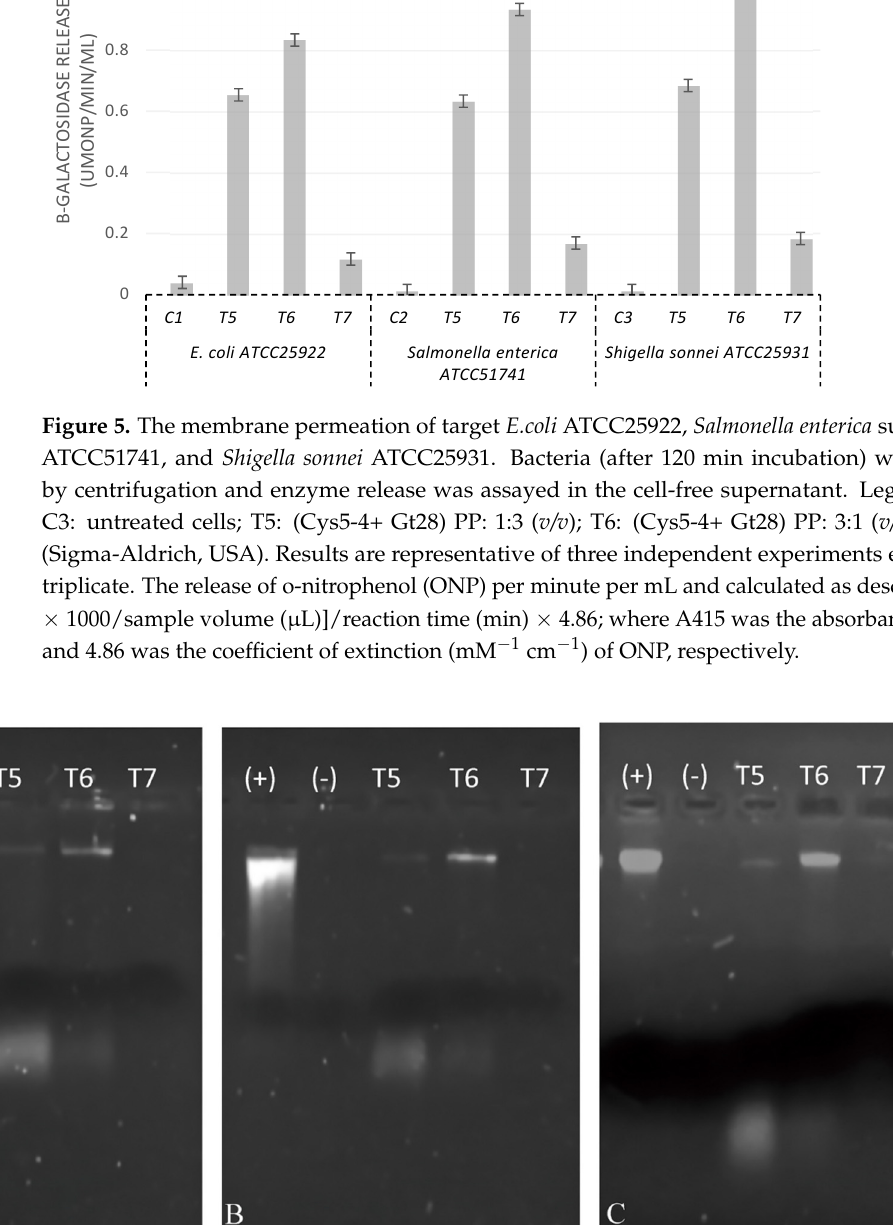
Figure 6. Leakage of DNA/RNA molecules from: upon the treatment with the antimicrobial cocktails. Legend: (+) genomic DNA of E. coli ATCC25922 ( A ), Salmonella enterica ATCC51741 ( B ), Shigella sonnei ATCC25931 ( C ) (-) negative control (no antimicrobial tested); T5: (Cys5-4+ Gt28)PP: 1:3 ( v/v ); T6: (Cys5-4+ Gt28)PP: 3:1 ( v/v ); T7: nisin (Sigma-Aldrich, USA).